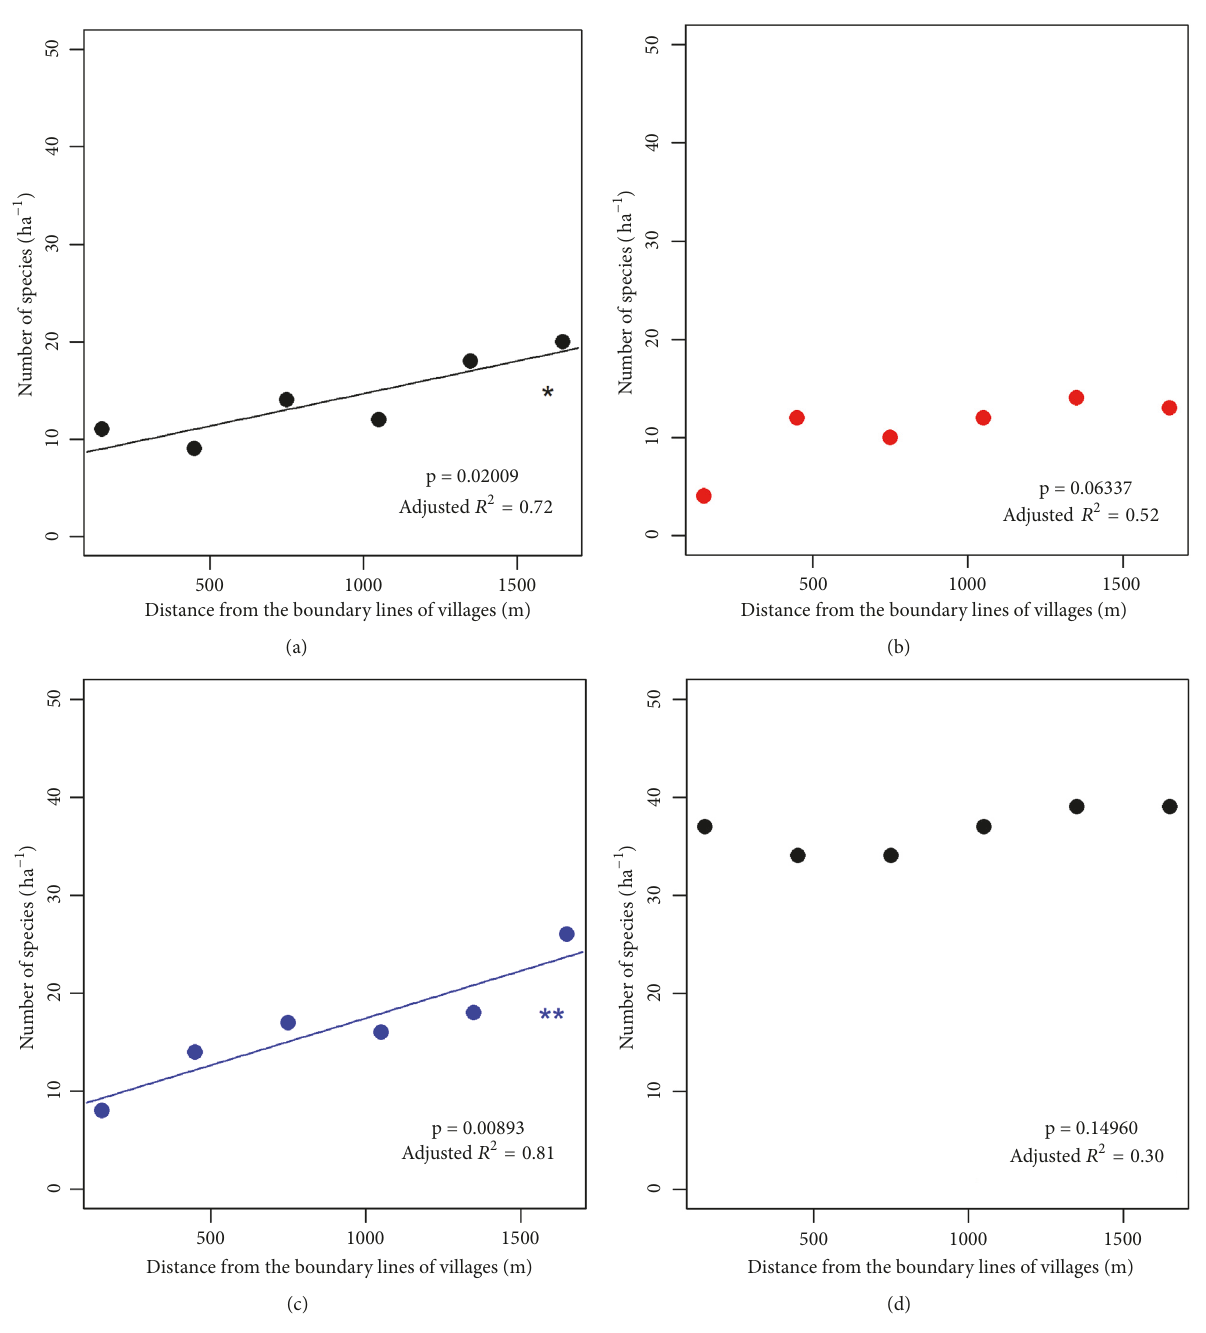
Figure 5: Observed species richness (species ha −1 ) plotted against the distance from the village boundaries. (a) Janajagaran BZCF: significant (p < 0.05), (b) Musharni Mai BZCF: nonsignificant (p > 0.05), (c) Radha Krishna BZCF: significant (p < 0.01), and (d) Parsa Wildlife Reserve: nonsignificant (p >